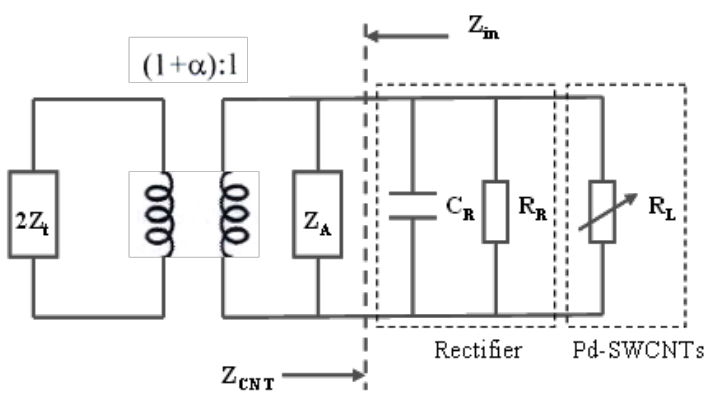
Figure 6. Schematic of the Sensor Tag.